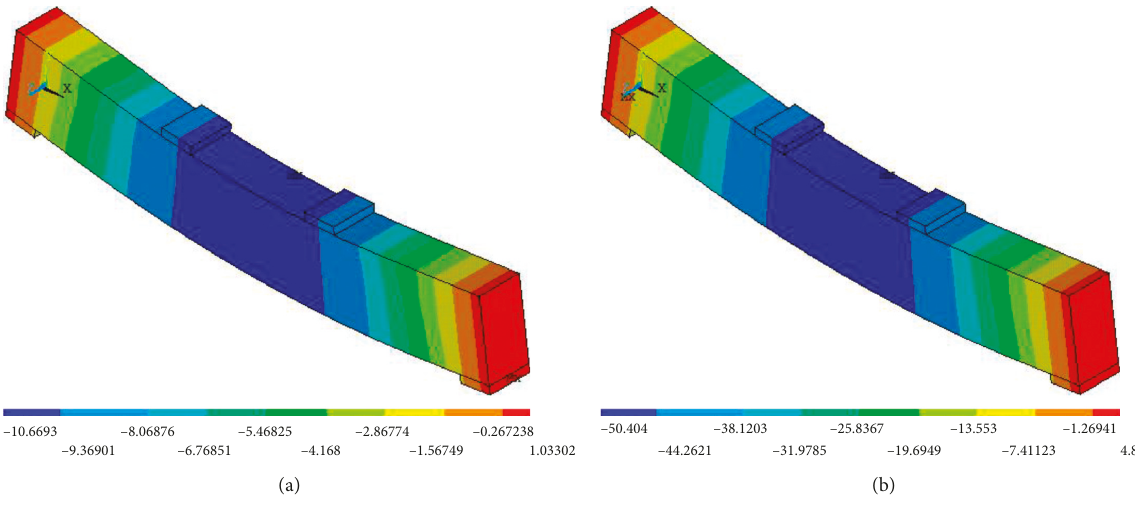
Figure 15: 3D views of deflections in the B7 model at (a) the yield load stage and (b) the maximum load